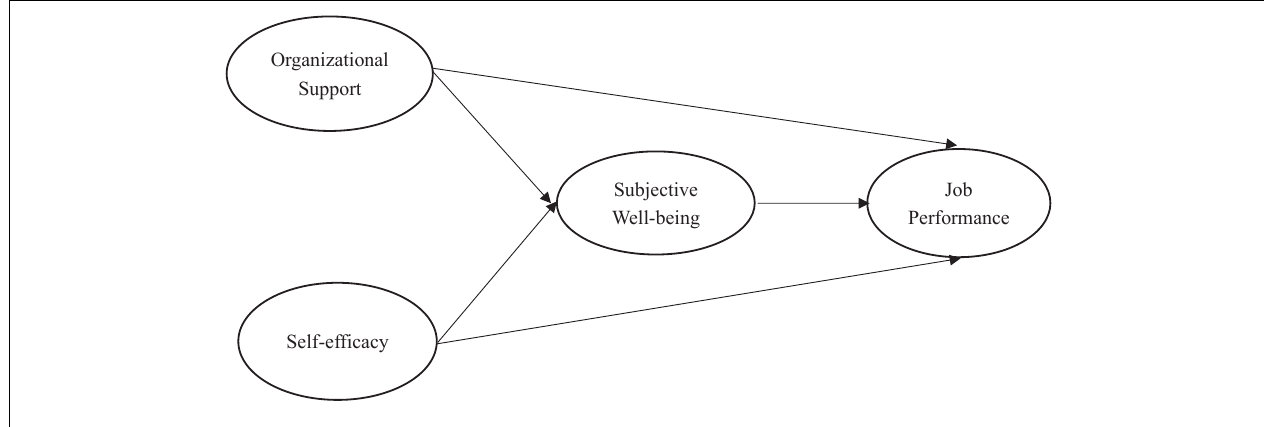
FIGURE 1 | Research